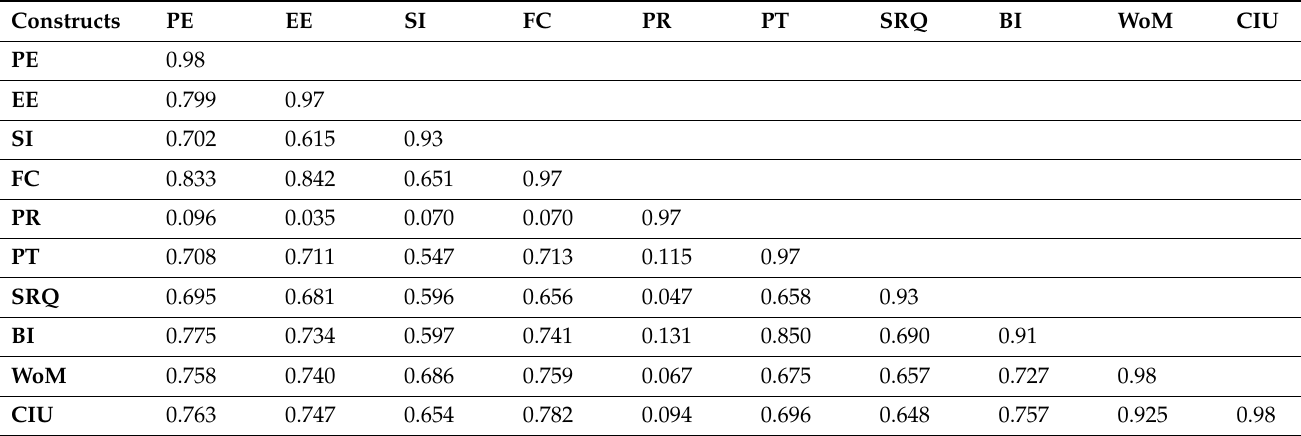
Table 6. Correlations of